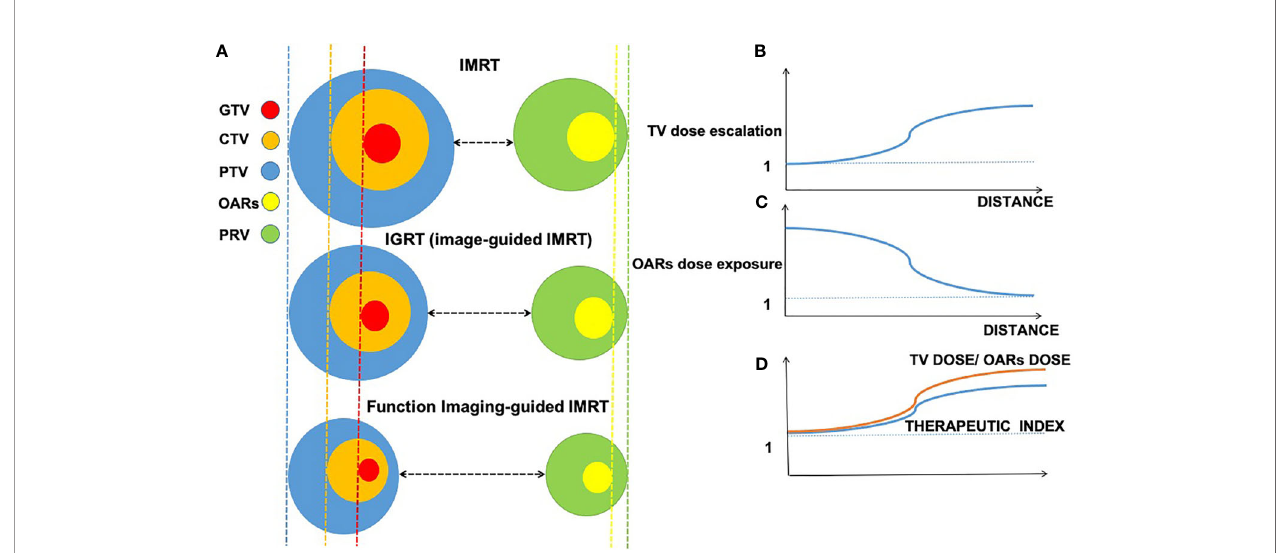
FIGURE 1 | Interaction among imaging-guided techniques, treatment margins of tumor target, and organs at risk (OARs) based on the accuracy of imaging approaches. Decreasing volume around gross tumor volume (GTV, in red), clinical target volume (CTV, in orange), planning target volume (PTV, in blue), planning organ at risk volume (PRV, in green), and organs at risk (OARs, in yellow); distance changes between treatment margins and OARs in intensity-modulated radiation therapy (IMRT), image-guided radiation therapy (IGRT), and function imaging-guided IMRT. (A) Relations between distance (x-axis) of gross target and organ at risk. (B) Relations between the distance (x-axis) and TV dose escalation (y-axis). (C) Relations between the distance (x-axis) and OARs dose exposure (y-axis). (D) Relations between TV dose/OARs dose and therapeutic